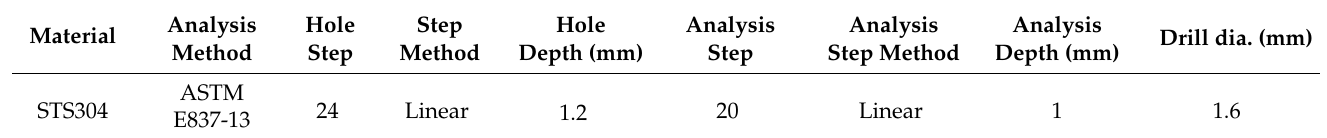
Table 4. Hole drilling test parameters for residual stress measurement.